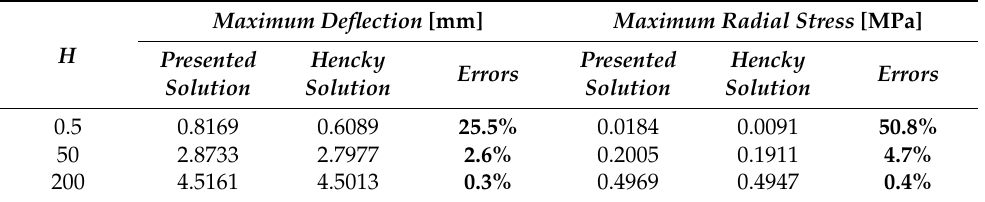
Figure 4. Radial stress σ r along radius r when H takes 0.5 mm, 50 mm and 200 mm, respectively, where the solid lines represent the solution presented in this paper and the dotted lines represent the well-known Hencky solution. Table 1. Maximum deflection and radial stress values at different H calculated by the solution presented in this paper and the well-known Hencky